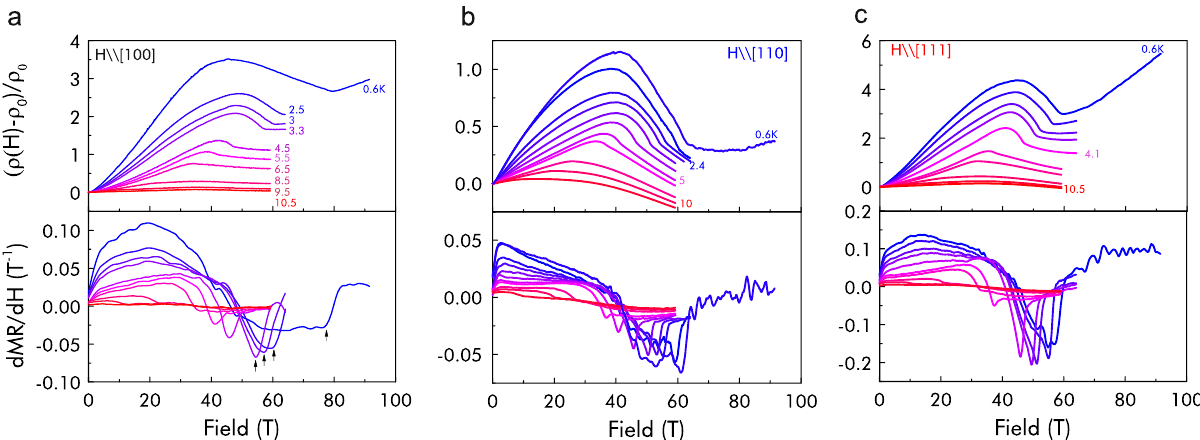
Fig. 3 Magnetoresistance of CeIn 3 at various temperatures for fi eld applied along the directions ( a ) [100], ( b ) [110], and ( c ) [111]. The lower panels display the fi eld derivative of the magnetoresistance d MR /d H shown in the upper panels . The minimum in d MR /d H identi fi es the critical fi eld needed to suppress the